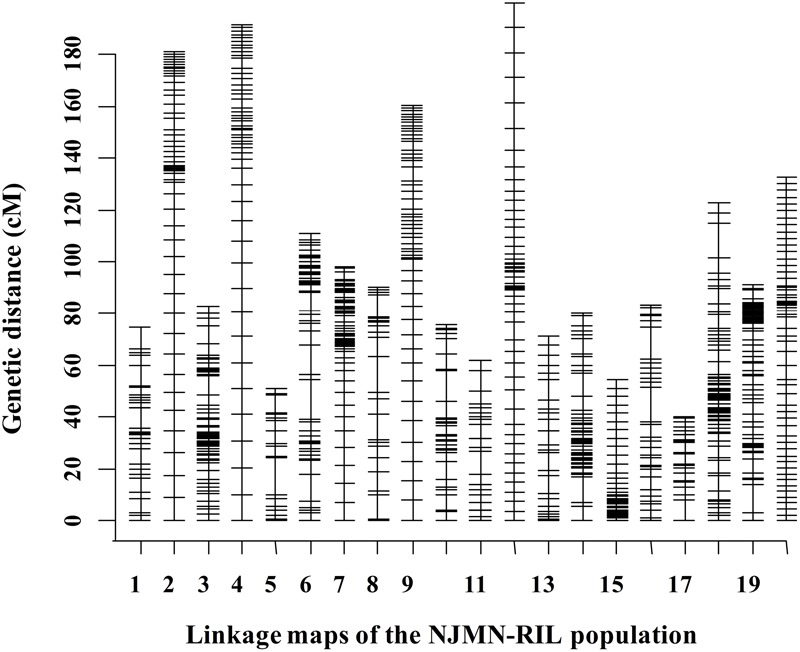
Distribution of markers in 20 linkage groups (LGs) in the NJMN-RIL population. The black bars in each LG represent mapped SLAF-seq markers. Detailed information is presented in Supplementary Table S2.